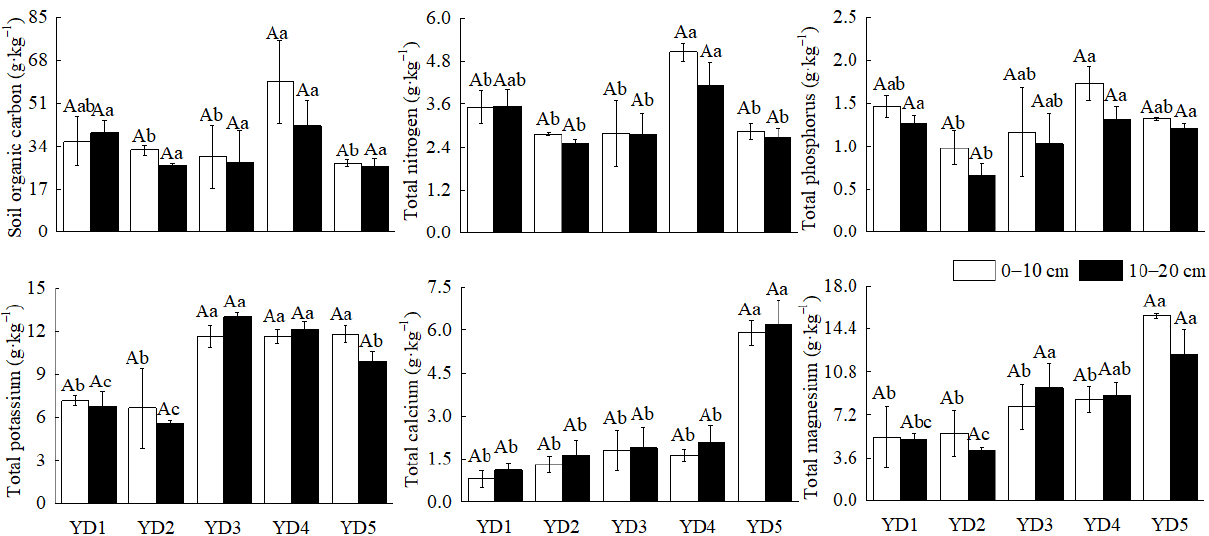
Figure 1. Soil element contents of Z. planispinum plantations for different allocations. YD1: Z. planispinum + P. salicina ; YD2: Z. planispinum + S. tonkinensis ; YD3: Z. planispinum + A. hypogaea ; YD4: Z. planispinum + L. japonica ; YD5: Z. planispinum pure plantation. The same notation is used in the other